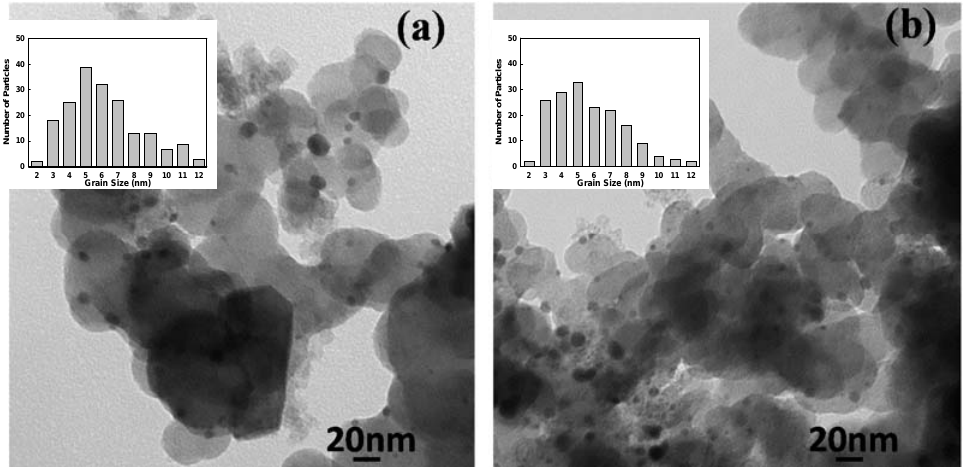
Figure 8. TEM images of Pt 0.75 Mn 0.25 samples prepared ( a ) without additive and ( b ) in the presence 2X of sodium citrate and heat treated at 700 °C for 1